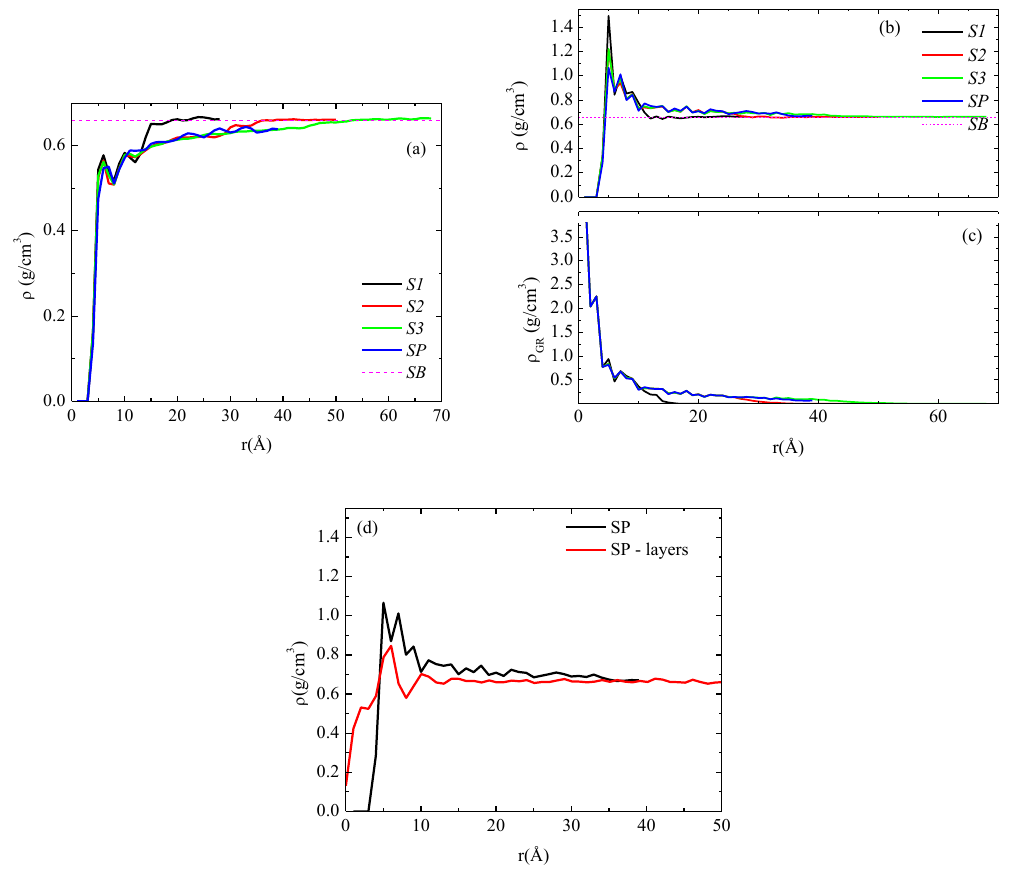
Figure 2. ( a ) Mass monomer density profiles of polyethylene as a function of r (distance from the center of the graphene layer) for the five systems studied here; ( b ) Density profiles of polyethylene chains excluding the volume occupied by graphene; ( c ) Mass density profiles of graphene layer as a function of r ; ( d ) Density profile of polyethylene chains for the periodic graphene layer analyzed via spherical shells and parallel